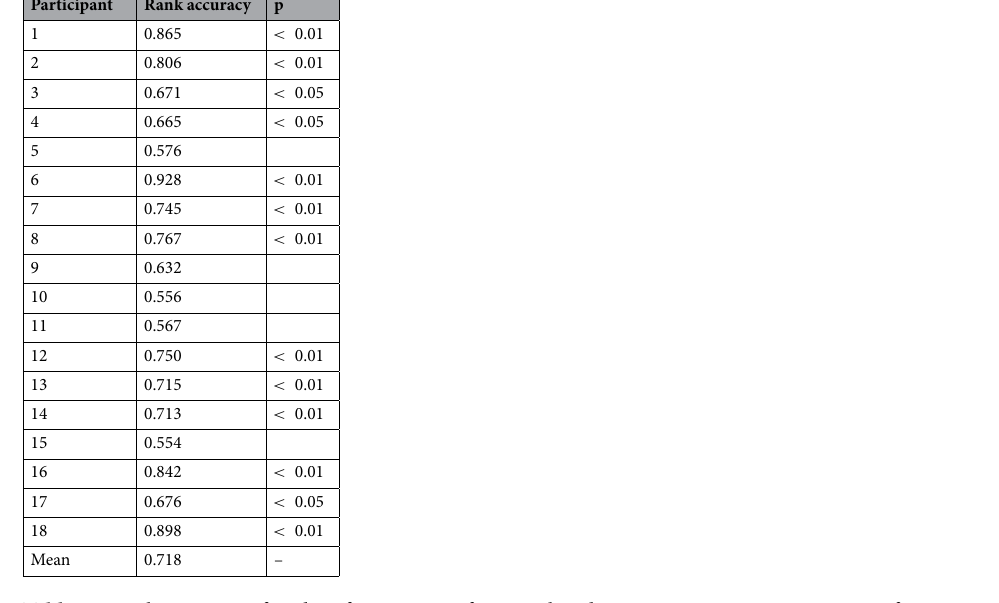
Table 2. Rank accuracies for identifying pieces of music played to participants in our joint EEG-fMRI